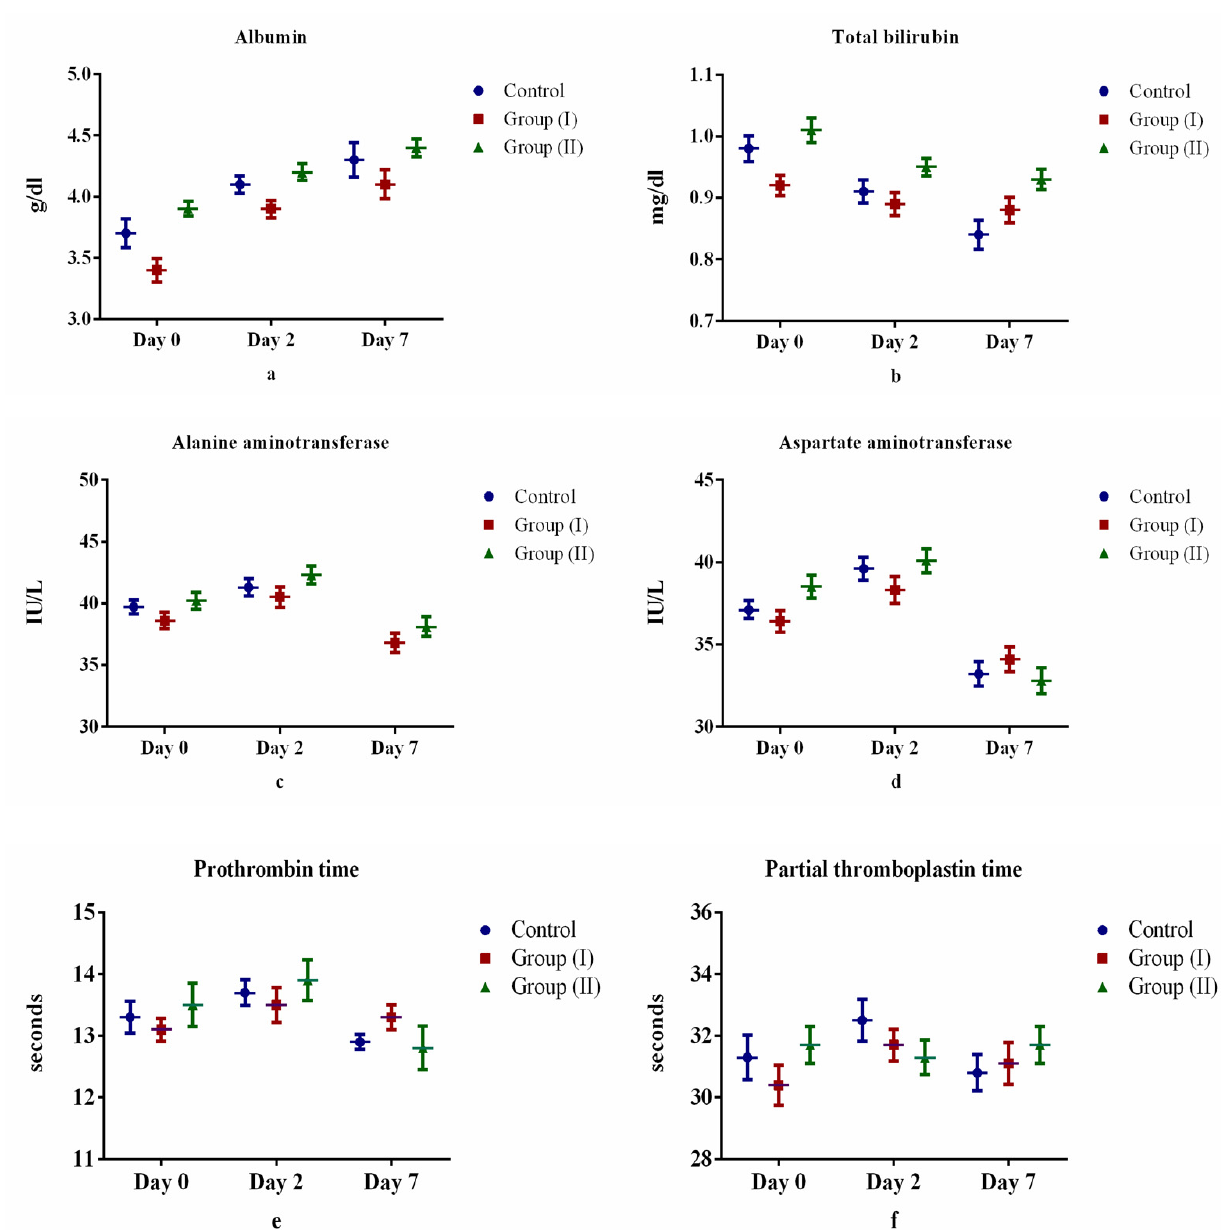
Figure 3. Comparison of liver function tests between control and treatment groups: ( a ) albumin, ( b ) total bilirubin, ( c ) alanine aminotransferase, ( d ) aspartate aminotransferase, ( e ) prothrombin time, ( f ) partial thromboplastin time.